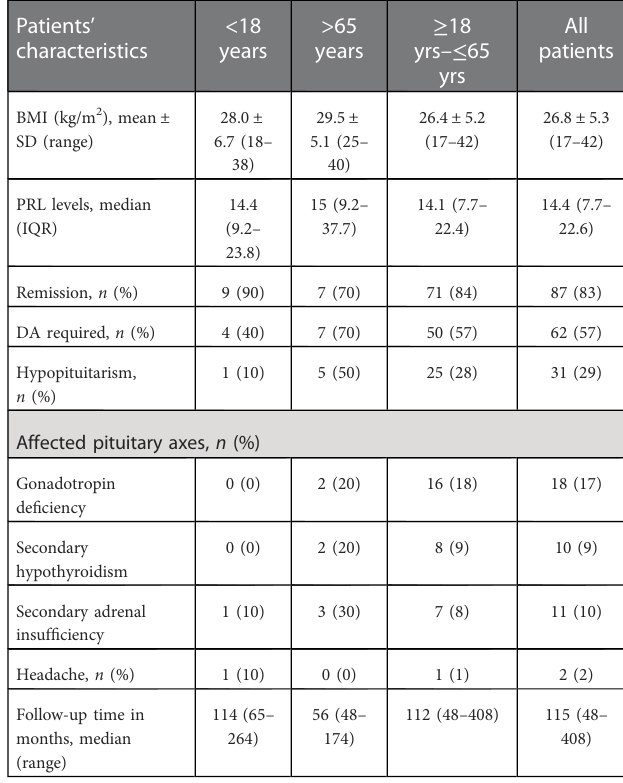
TABLE 2 Patient characteristics at long-term follow-up. Patients ’